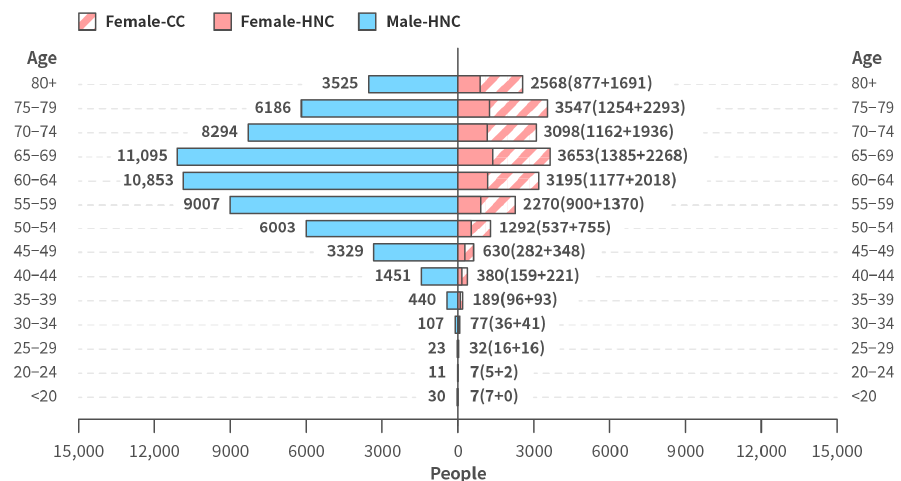
Figure 2. Age and sex distribution of patients who would otherwise be alive in 2019 had they not died from HNC or CC between 1970 and 2019.